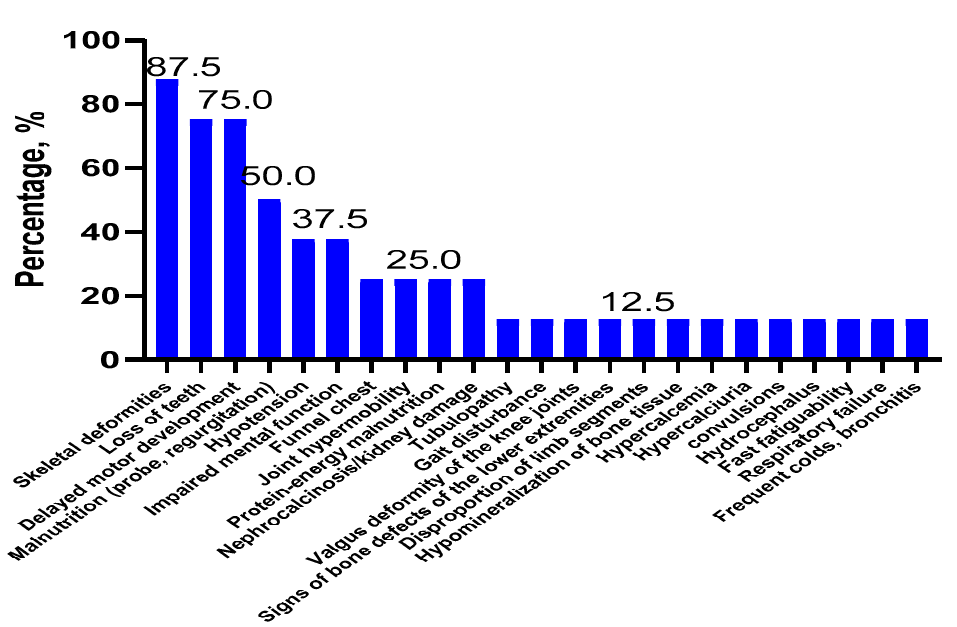
Figure 3. Clinical symptoms of HPP in children with infantile HPP ( n = 8). In patients with childhood HPP ( n = 10), the most frequent symptoms were tooth loss (100.0%), hypomyotonia (60.0%), skeletal deformity (40.0%), gait disorder (40.0%), muscle and joint pain (40.0%) neuropsychomotor developmental delay (40.0%), and fatigue (40.0%) (Figure 4).